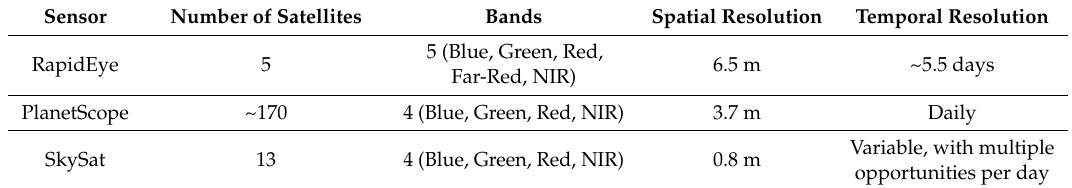
Table 1. Specifications of the three satellite sensors operated by Planet. Information is correct as of date of